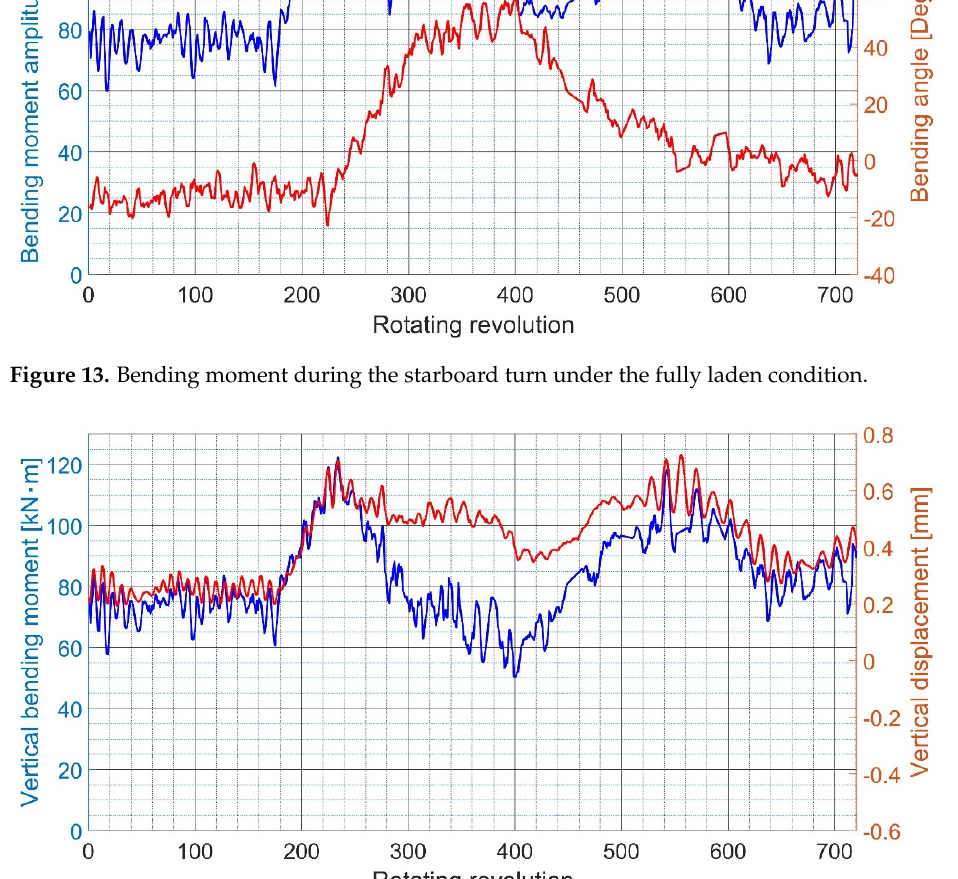
Figure 14. Bending moment and displacement behavior in the vertical direction during the starboard turn under the fully laden condition.